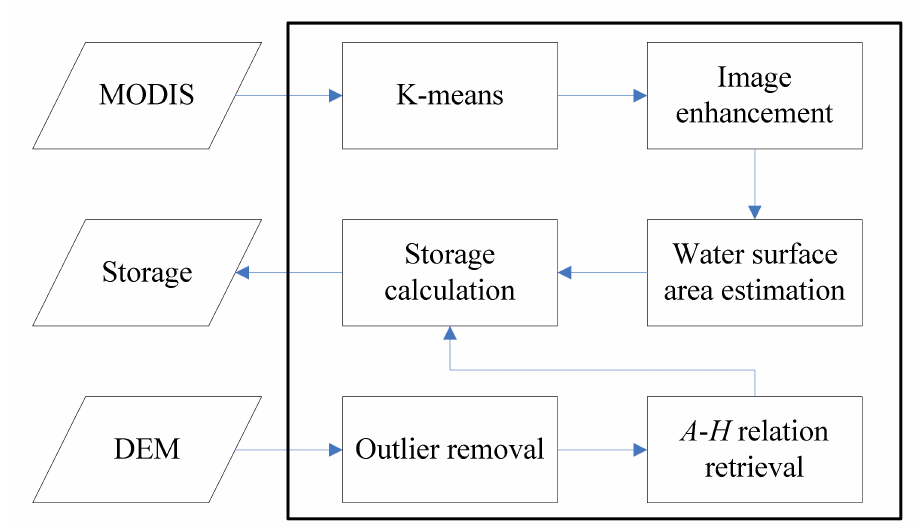
Figure 2. Flowchart of the MODIS-SRTM based reservoir storage estimation